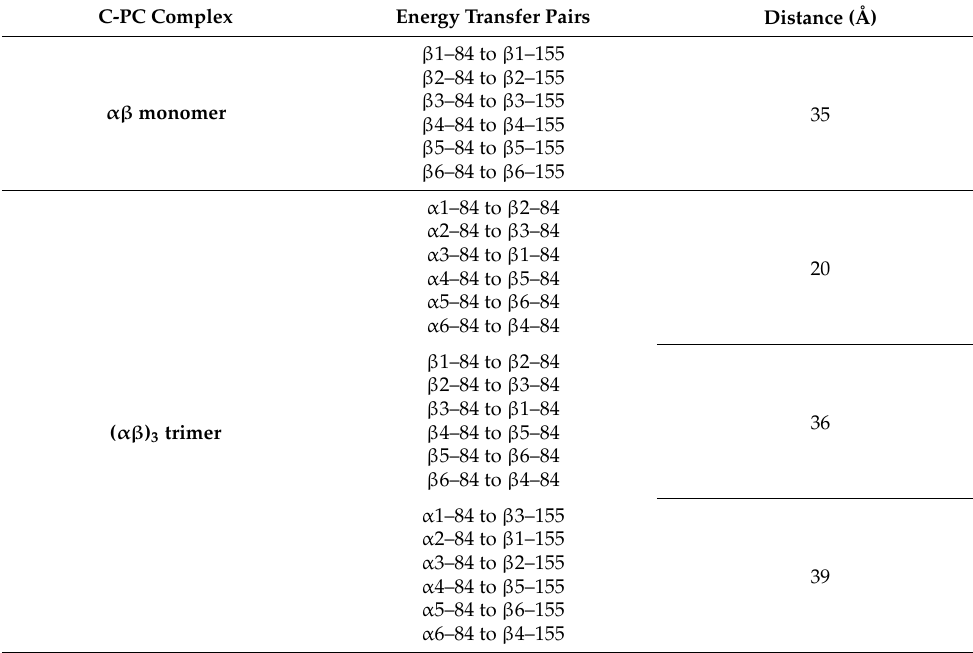
Table 1. Distances (<40 Å) between chromophores within the C-PC complex. C-PC Complex